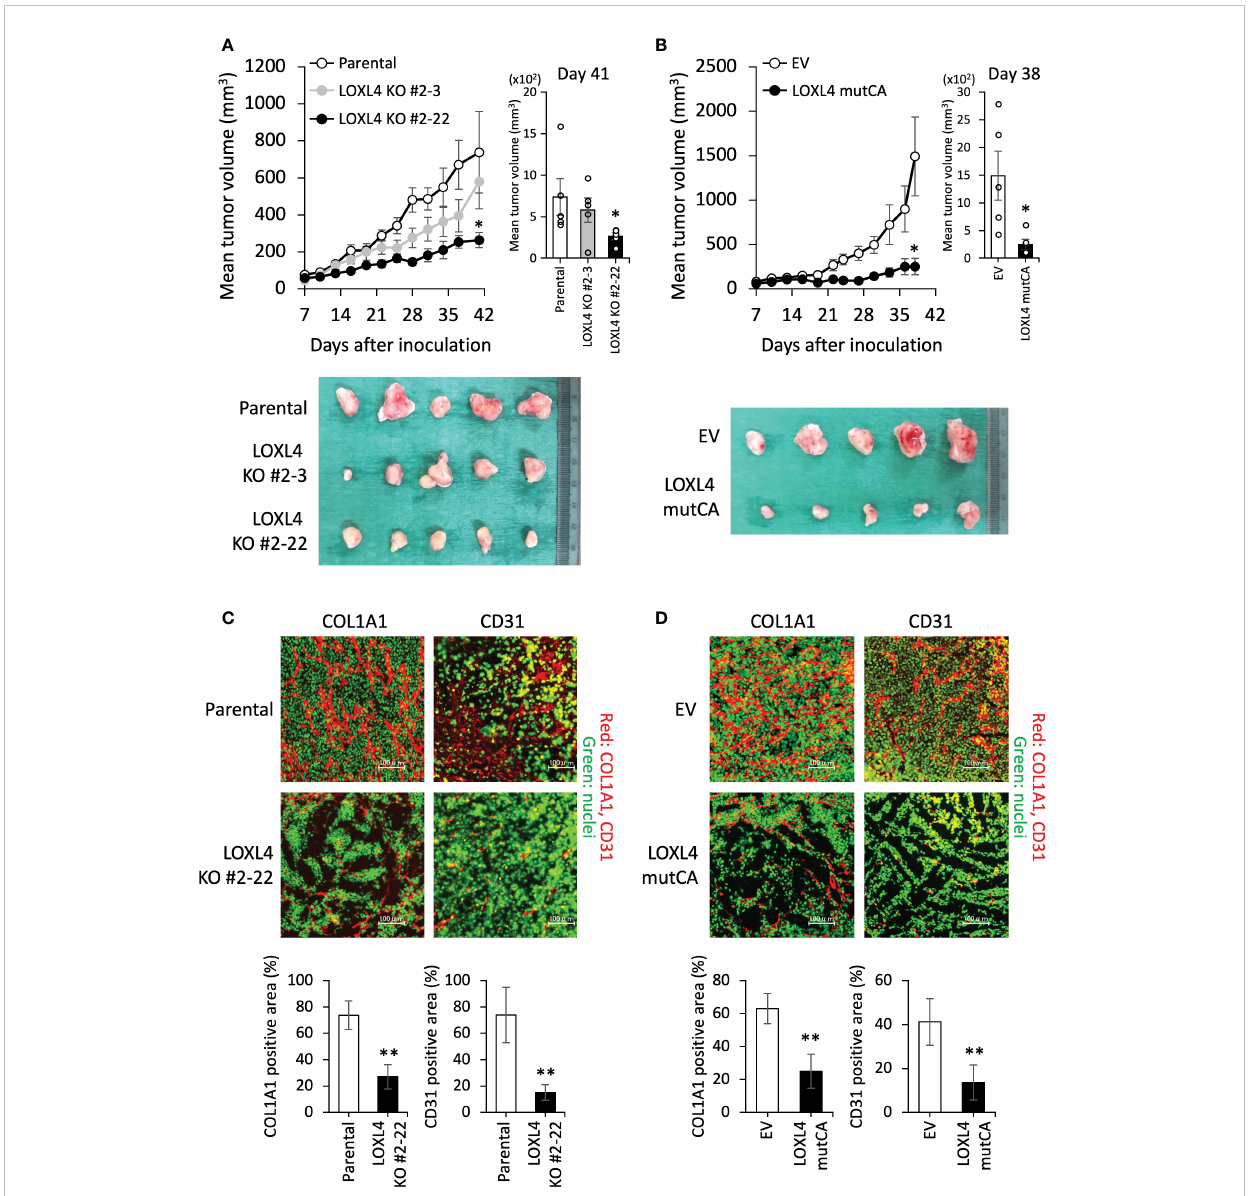
FIGURE 2 The effects of the genetic deletion and catalytic de fi ciency of LOXL4 on cancer cell growth in vivo . (A, B) : In the orthotopic xenograft mouse model, a tumor growth curve was established after injection of the indicated cells (A) : parental cells and LOXL4 KO sublines, (B) : control empty vector (EV) and LOXL4 mutCA sublines). The tumor diameters were measured ( upper (line graphs of chronological evaluation: left , bar graphs at the end of assessment: right )), and photographs of the dissected tumors were taken ( lower ). Data are mean±SEM (n=5) for animal experiments. *p<0.05. (C, D) : The resected-tumor sections were immuno fl uorescence-stained by the indicated antibodies (C) : parental cells and LOXL4 KO sublines, (D) : control empty vector (EV) and LOXL4 mutCA sublines). The SYBR ® Green I staining detected nuclei. The bars in the images represent 100 m m. The staining images were exhibited on the upper side, and their quanti fi ed data were displayed on the lower side. Data are mean±SD.